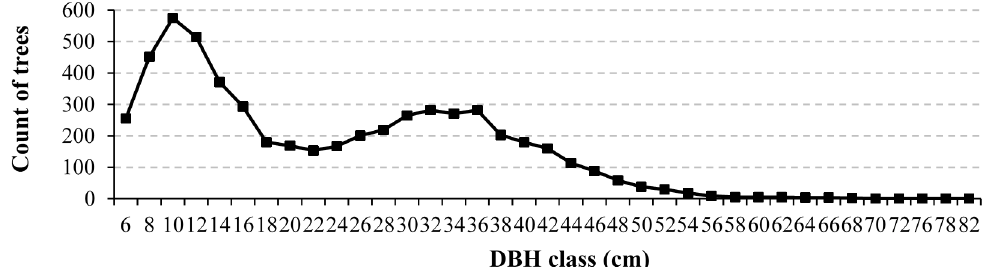
Figure 2. Frequency distribution of all trees in the study area with a DBH larger than 5 cm. The x-axis shows the DBH class; for example, the “6” and “10” classes represent the trees with DBHs ranging from 5 to 7 cm and from 9 to 11 cm, respectively. The y-axis shows the number of trees included in each DBH class.